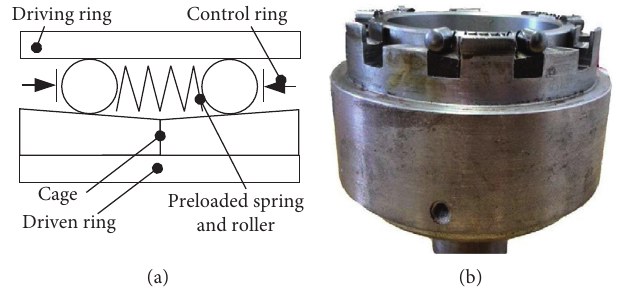
Figure 3: The roller type SOWC. (a) Schematic diagram. (b) Actual